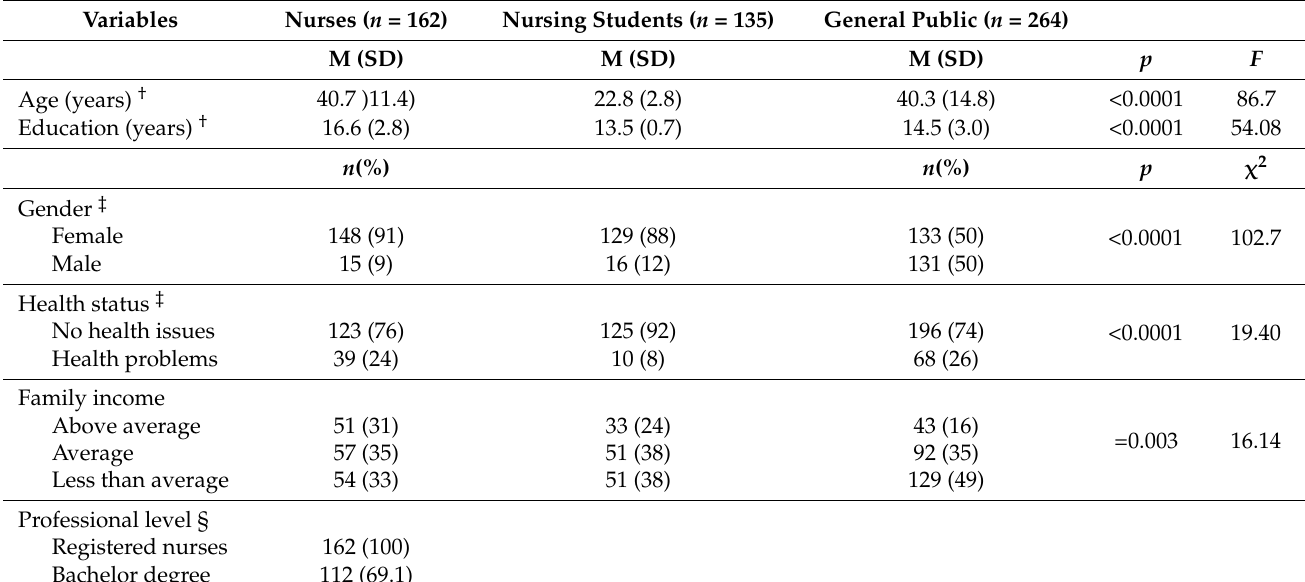
Table 1. Comparison of the sociodemographic characteristics of nurses, nursing students, and the general public ( n = 561).